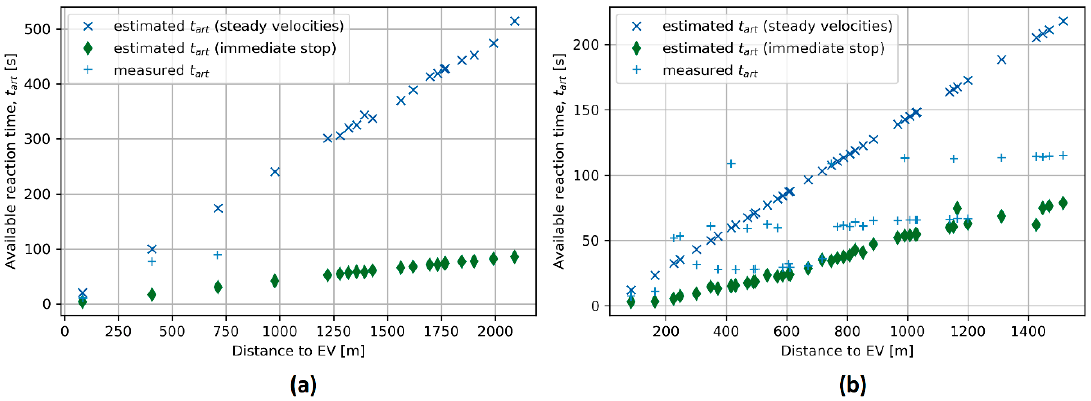
Figure 8. The available reaction time as a function of the distance between the EV and the vehicle, in ( a ) the Žilina scenario and in ( b ) the Bratislava scenario.